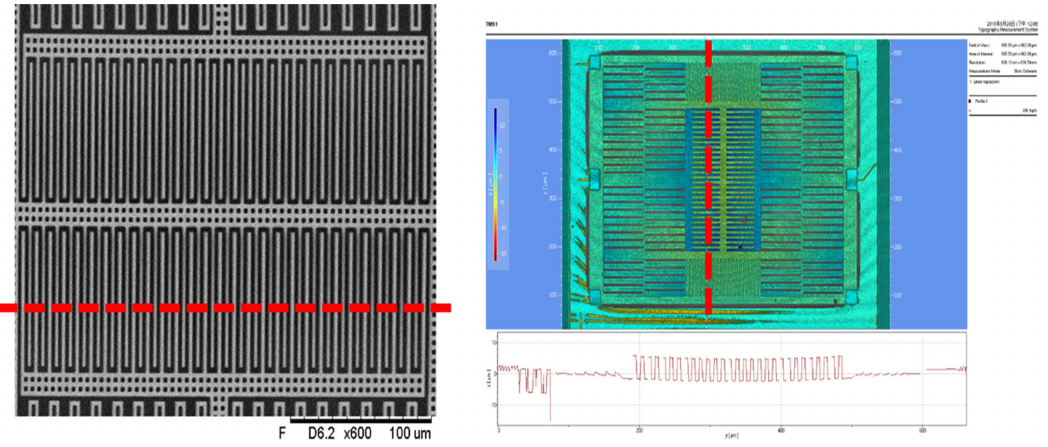
Figure 24. Surface height measurements of the sensing electrodes along the Y -axis.